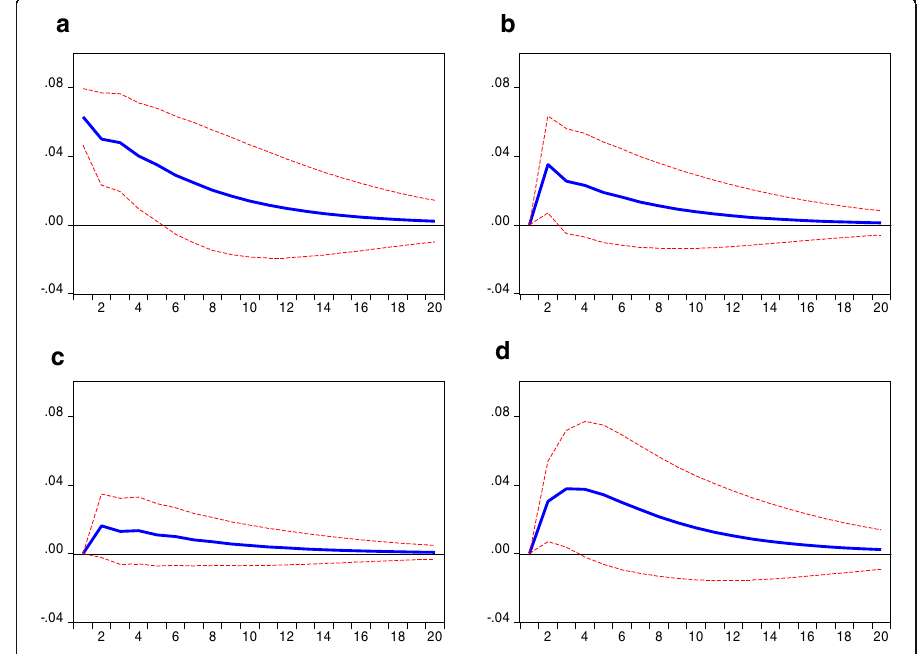
Fig. 4 Response to Cholesky to one SD Innovation (±2 S. E. ). a Response of call rate to call rate. b Response of call rate to M2 money growth. c Response of call rate to income growth. d Response of